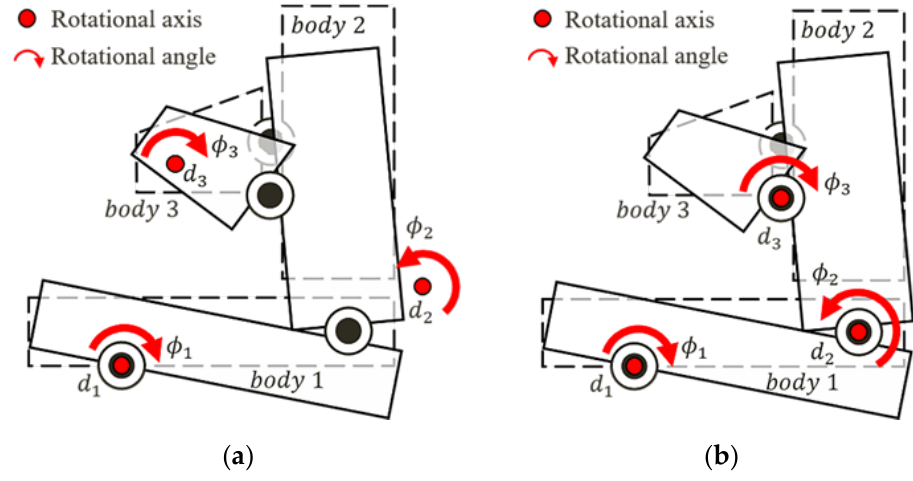
Figure 4. Rotational axes found by using different coordinates: ( a ) absolute; ( b ) relative.